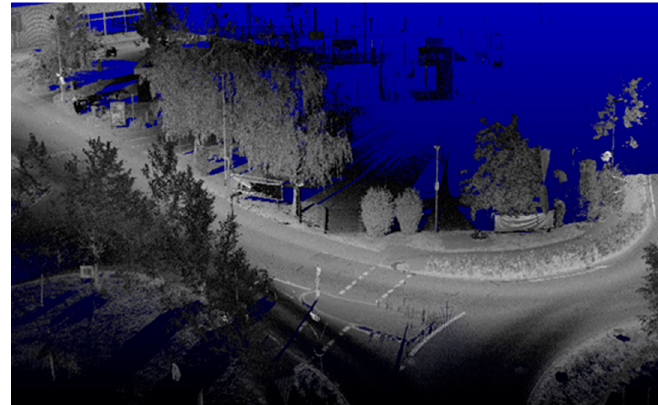
Figure 1. Three-dimensional point cloud (intensity values depicted in grayscale).